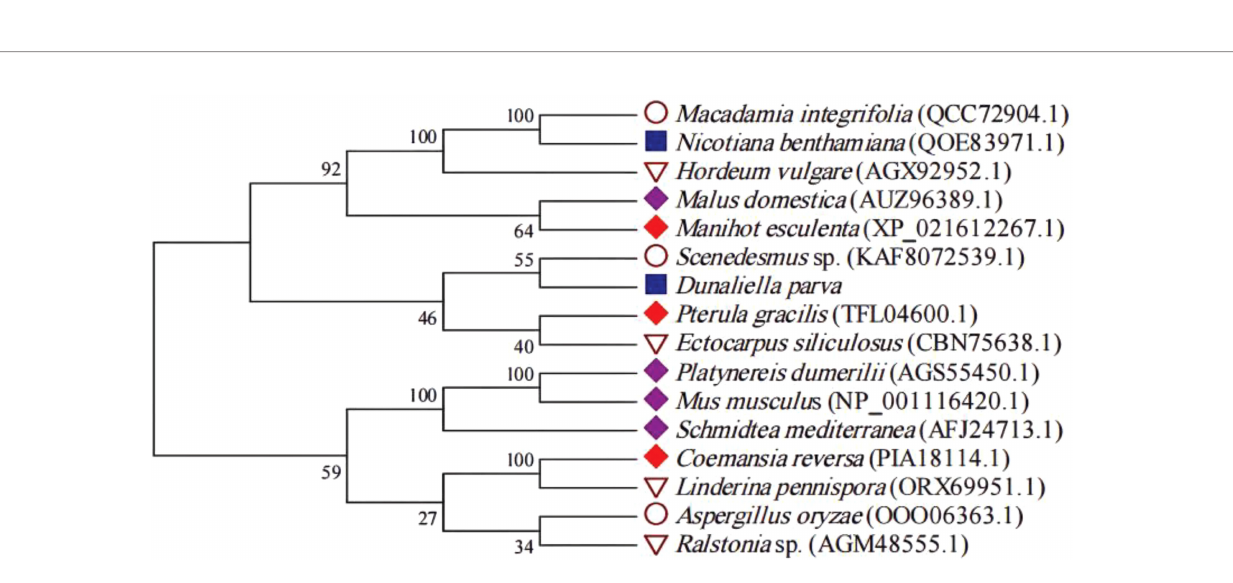
Column was used to select DNA molecules more than 200 bp that were likely to encode the translated region of mRNAs. The cDNA was cloned into yeast strain Y187 along with AD plasmid pGADT7-Rec. Plasmid pGADT7-Rec and cDNA fragments were